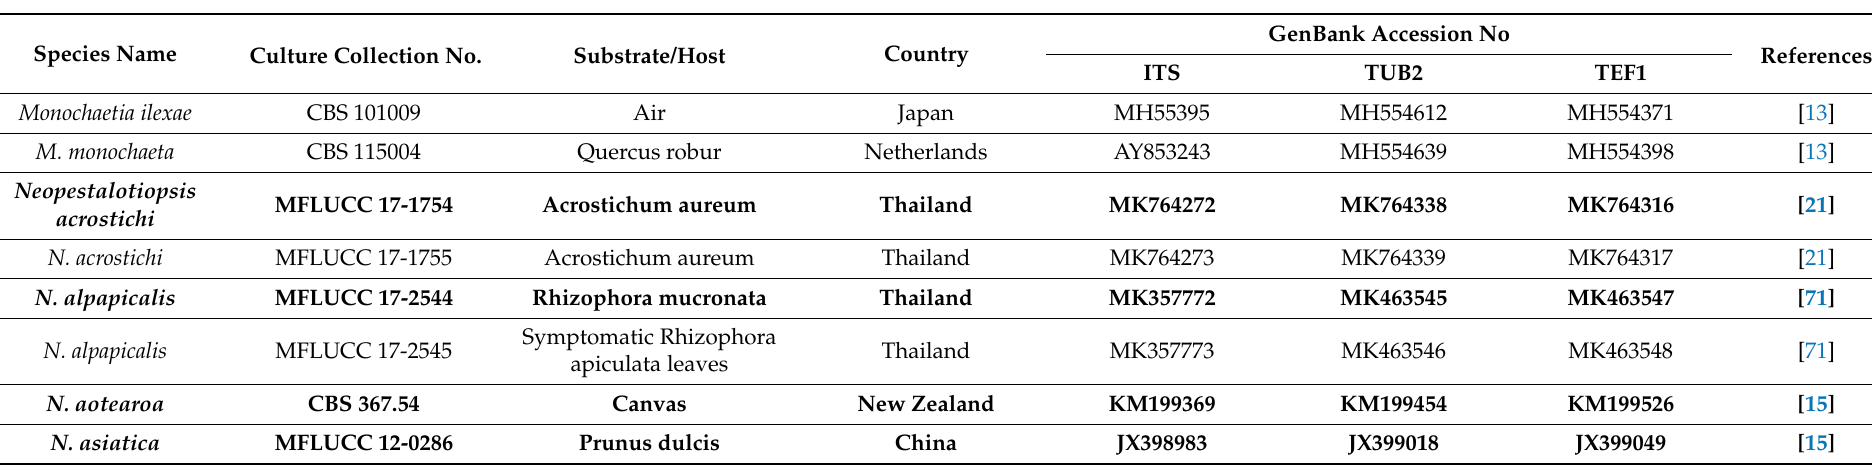
Table 2. Culture collection numbers and GenBank accession numbers for Neopestalotiopsis used in this study. The type species are indicated in bold. The newly generated sequences are indicated in red. Instances where the GenBank Accession No. did not show the molecular data are marked with the